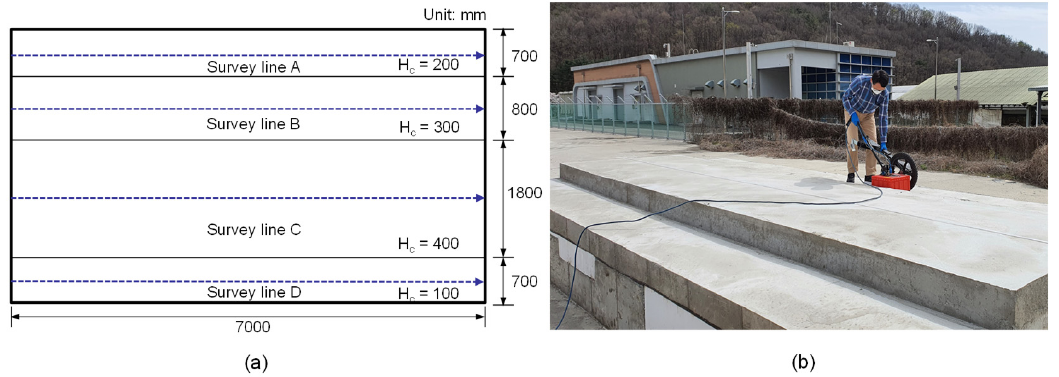
Figure 4. GPR survey on the concrete tunnel lining model specimen in this study: ( a ) plan for the GPR line scanning on the surface of concrete, and ( b ) photograph of GPR lining scanning through the test line B on the 300 mm thick concrete.